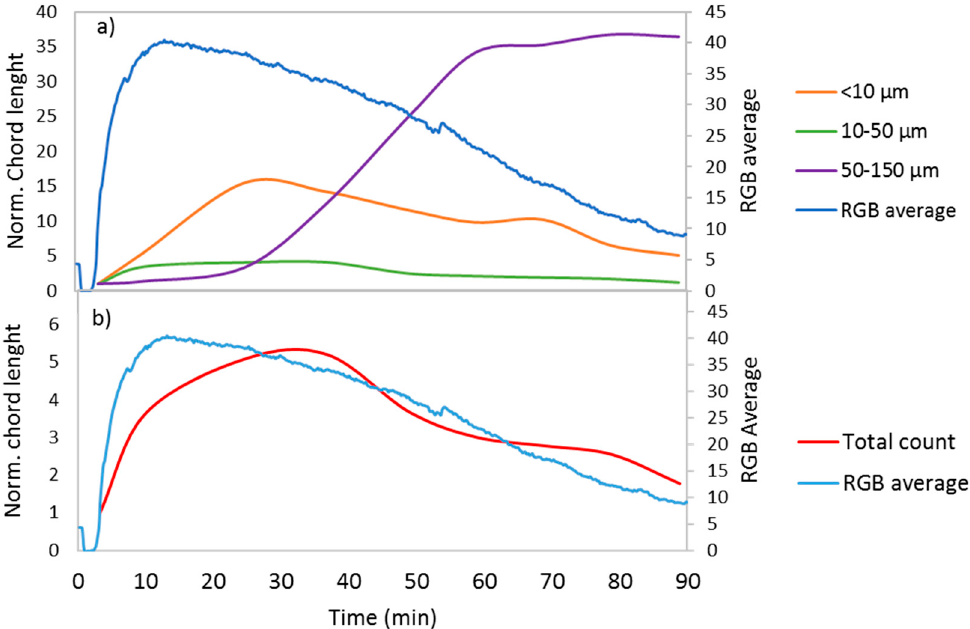
Figure 3. Normalized chord length and RGB average for a calcium carbonate precipitation process for ( a ) particles sized <10 µm, 10–50 µm, and 50–150 µm and ( b ) the total count.